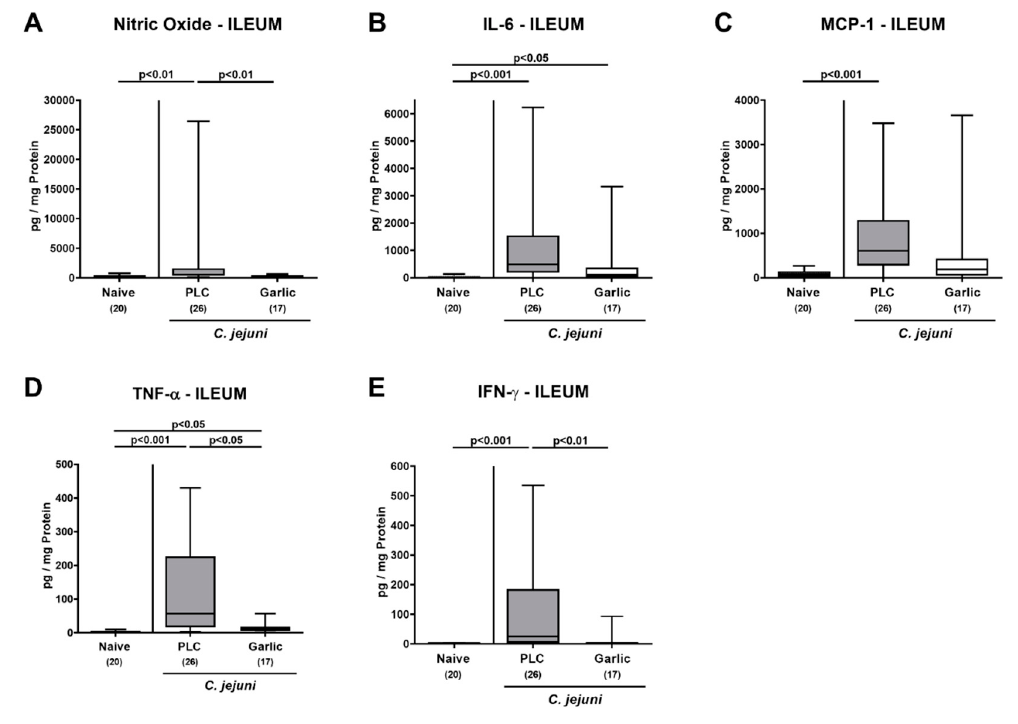
Figure 6. Pro-inflammatory mediator secretion in the ileum upon garlic essential oil treatment of C. jejuni infected IL-10 -/- mice. Secondary abiotic IL-10 -/- mice were orally challenged with C. jejuni strain 81–176 on days 0 and 1 followed by treat- ment with either garlic essential oil (white boxes) or placebo (PLC, gray boxes) via the drinking water starting on day 2 post-infection. ( A ) Nitric oxide, ( B ) IL-6, ( C ) MCP-1, ( D ) TNF- α and ( E ) IFN- γ concentrations were determined in culture